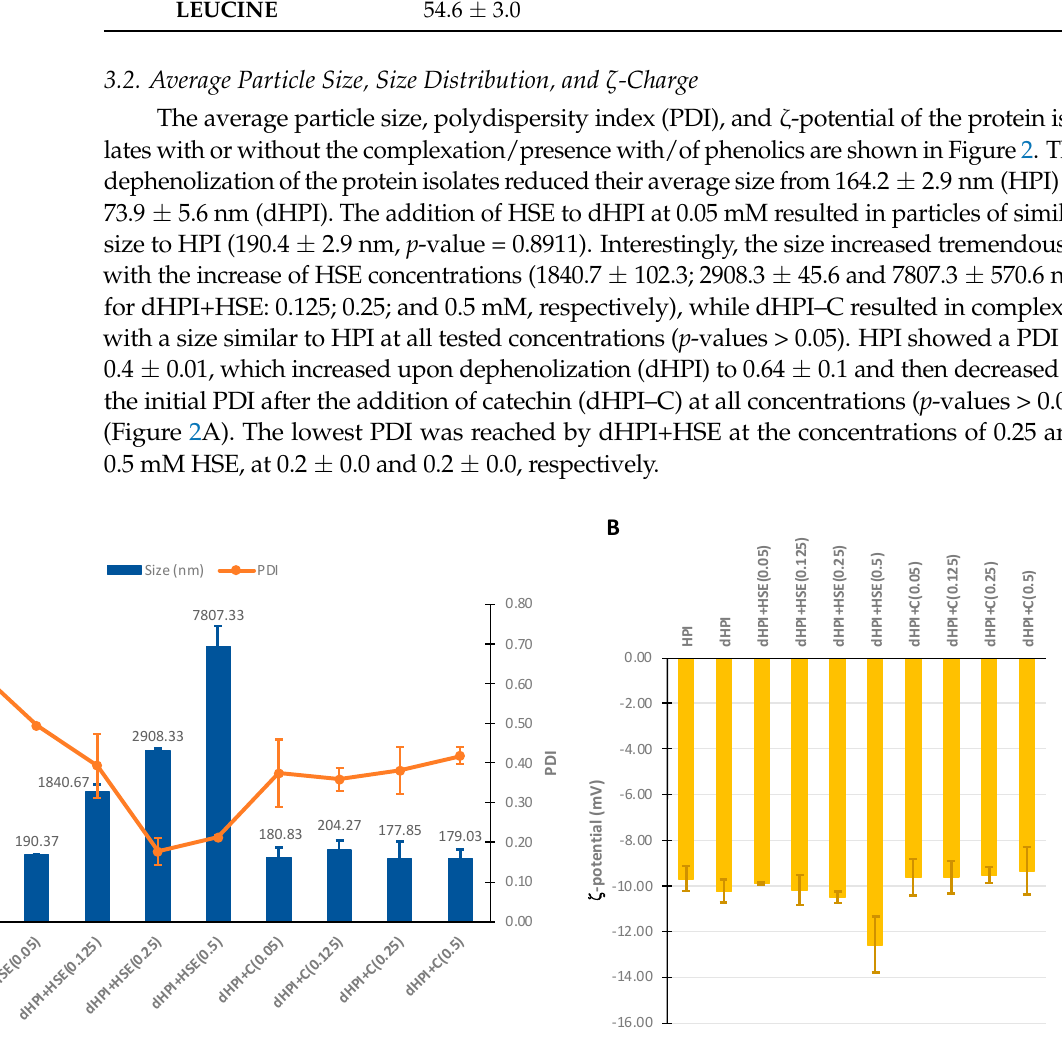
Figure 2. DLS results of hazelnut protein isolates (HPI), dephenolized HPI (dHPI), and dHPI+HSE/C complexes at different concentrations of phenolics (mM). ( A ) Average size and polydispersity index (PDI). ( B ) ζ -potential.